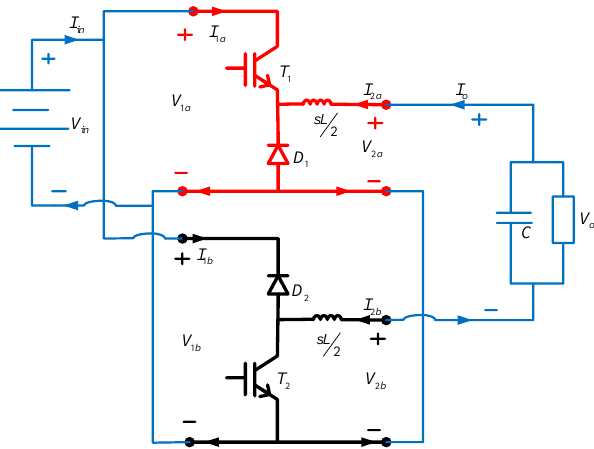
Figure 12. Refined circuitry of a voltage-fed DC-DC converter.